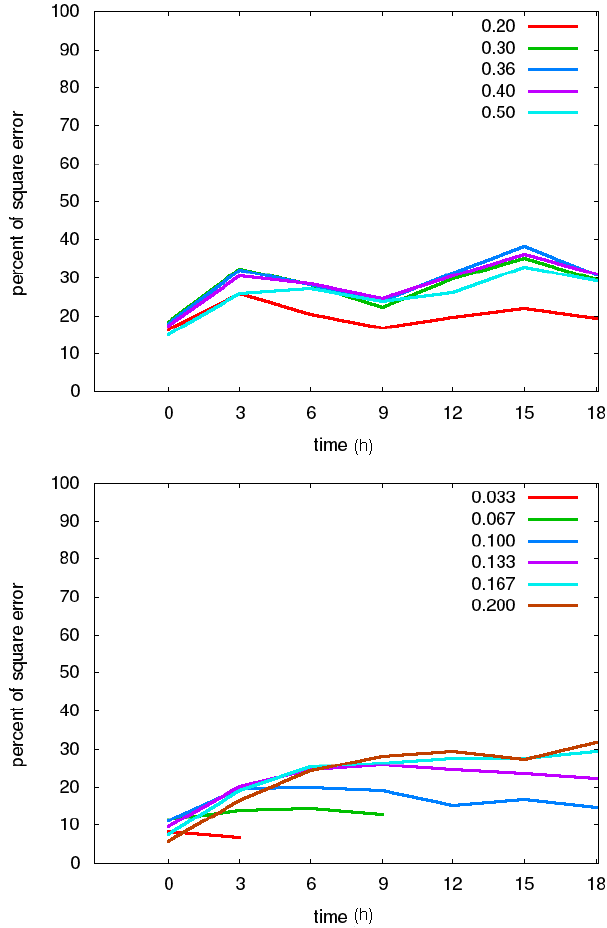
Figure 4. Square norm of forecast error orthogonal projection onto the subspace of the 12 leading bred vectors (percentage of error square norm) as a function of time. Different curves in each panel correspond to different rescaling norms. Top panel: control trajec- tory 18H (large initial error), rescaling period 30min, rescaling rms TUV norms from 0.20 to 0.50. Bottom panel: control trajectory R21 (small initial error), rescaling period 15min, rescaling rms TUV norms from 0.033 to 0.200. Times indicated on the x axis corre- spond to UTC times on 26 September 2006. The rescaling norm range in each panel should be compared with the corresponding control trajectory error in Fig. 1. The same data are plotted as a function of rescaling amplitude in Fig.